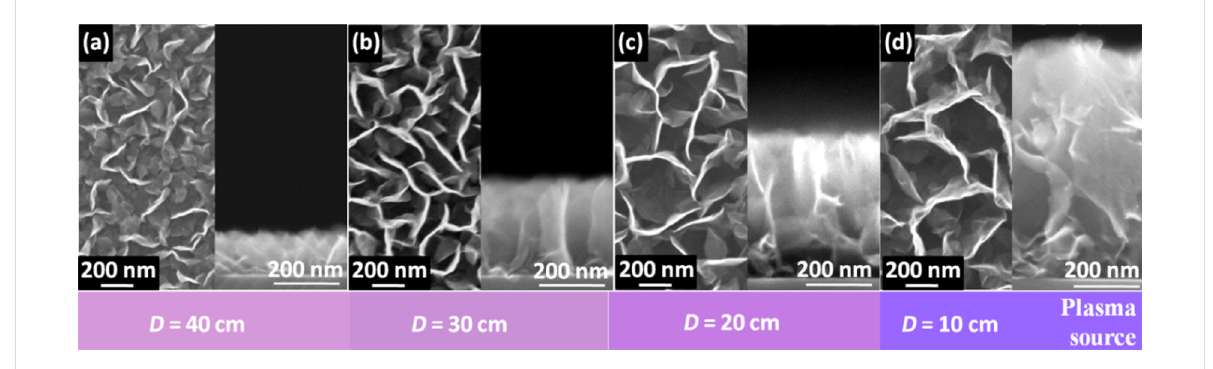
Figure 5: Scanning electron micrographs and corresponding cross sections of VGNs grown at different distances from the plasma source, namely, (a) 40 cm, (b) 30 cm, (c) 20 cm, and (d) 10